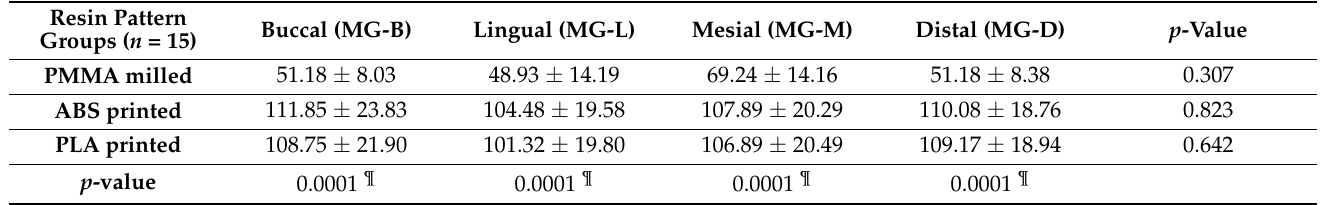
Table 2. Comparison of the marginal gap on all four walls among the three different resin patterns in